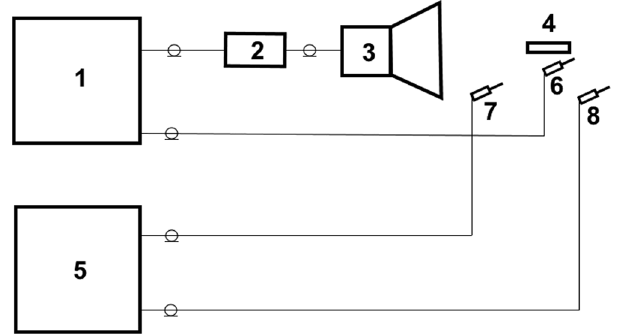
Figure 2. Experimental setup scheme. ( 1 ) Network analyzer. ( 2 ) RF broadband amplifier. ( 3 ) Double ridged waveguide horn antenna. ( 4 ) Dielectric ring. ( 5 ) Four channel oscilloscope. ( 6 ) High frequency probe of network analyzer. ( 7 ) Reference high frequency probe of oscilloscope. ( 8 ) High frequency probe of